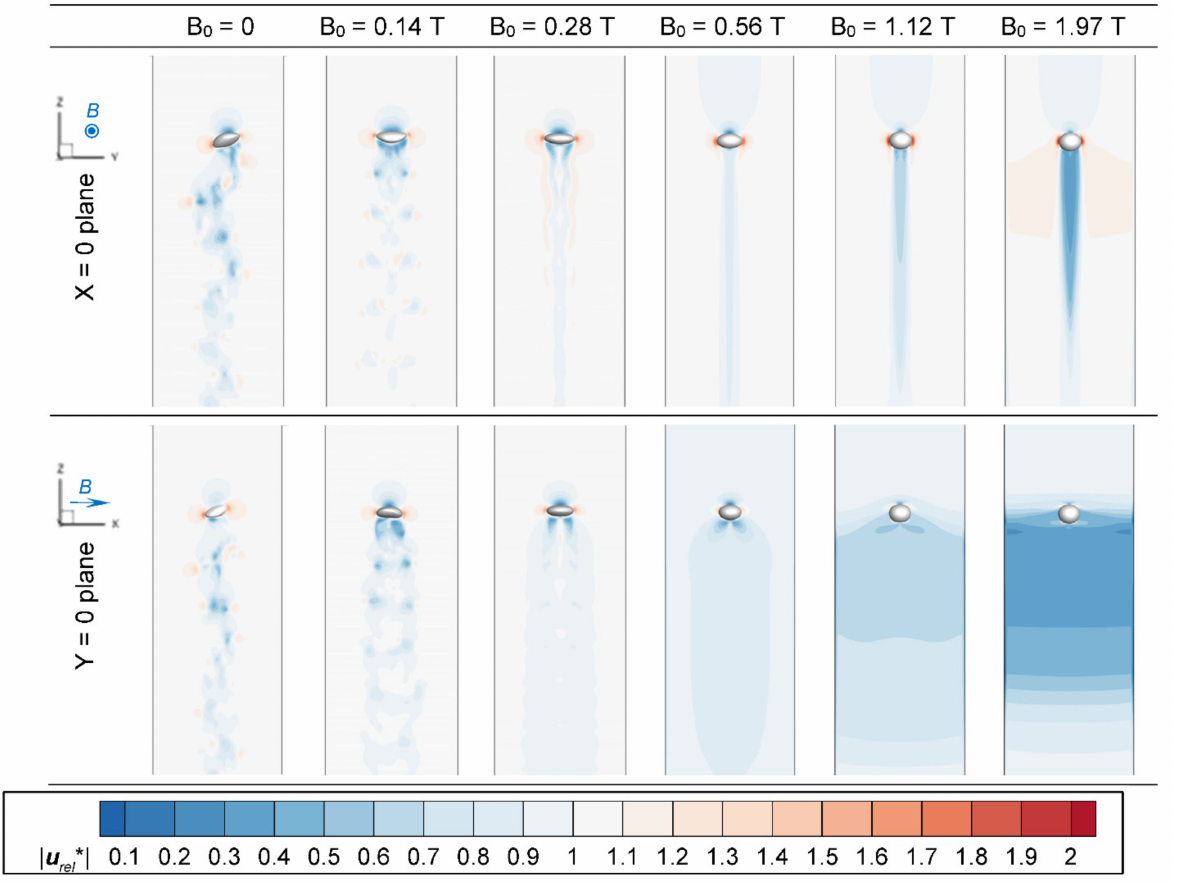
Figure 16. Distribution of the non-dimensional relative velocity | u rel ∗ | on the x = 0 plane ( top row ) and on the y = 0 plane ( bottom row ). The wake field is stabilized by the action of the Lorentz force and shows different features between planes x = 0 and y = 0 for higher B 0 ( ≥ 0.56